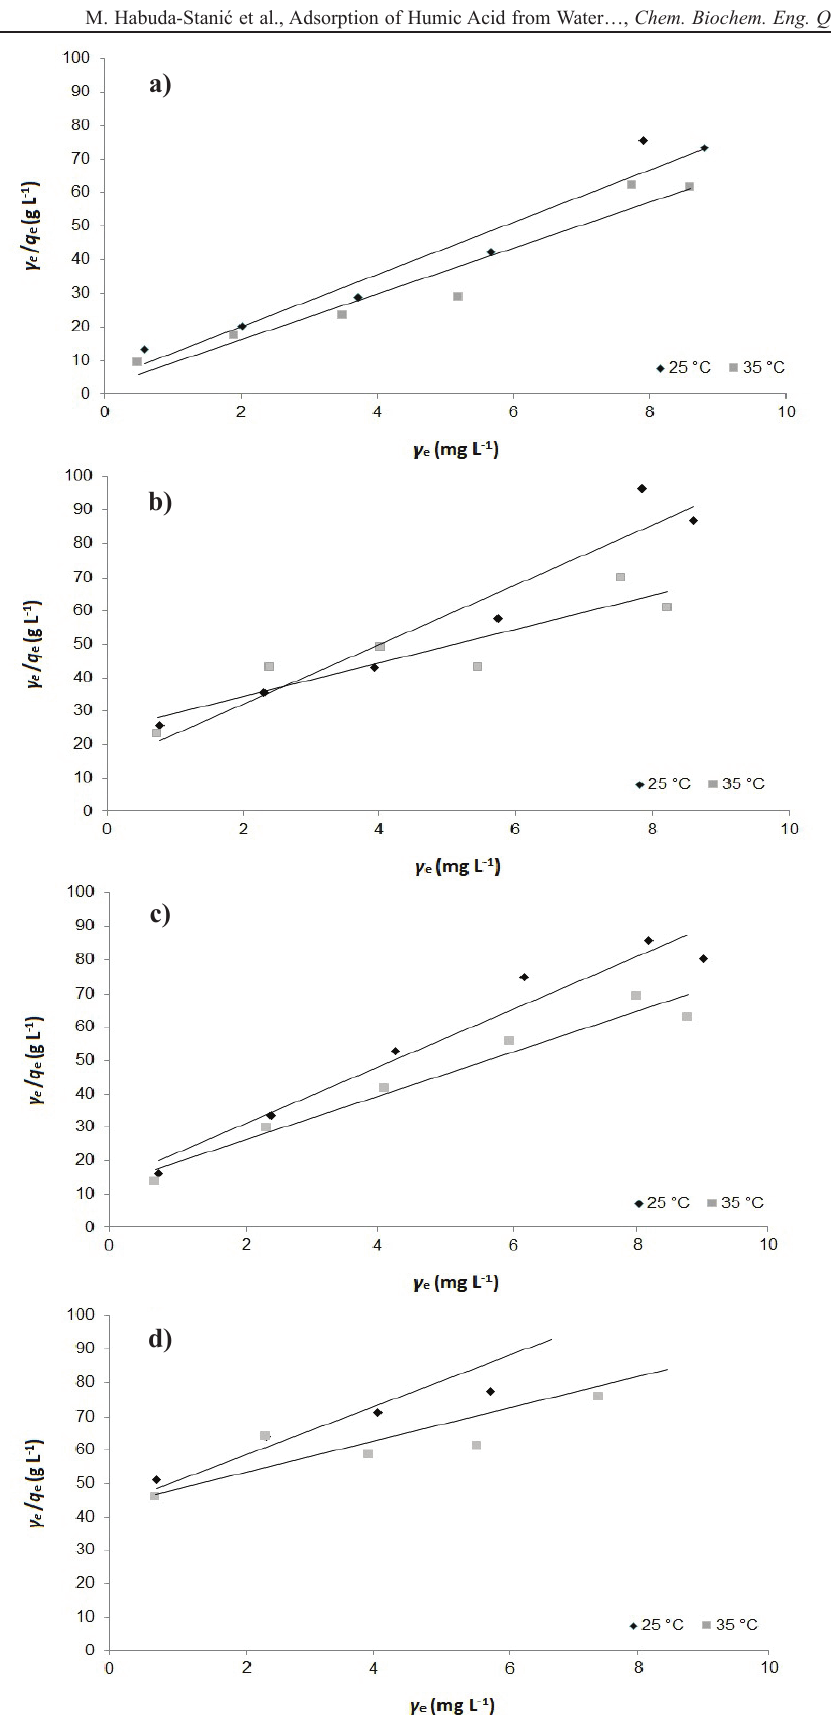
Fig. 8 – Langmuir isotherms for HA adsorption on (a) Cm1, (b) Cm2, (c) Hm1, and (d) Hm2 (γ V = 100 mL, pH = 7, t = 120 min, 120 solution